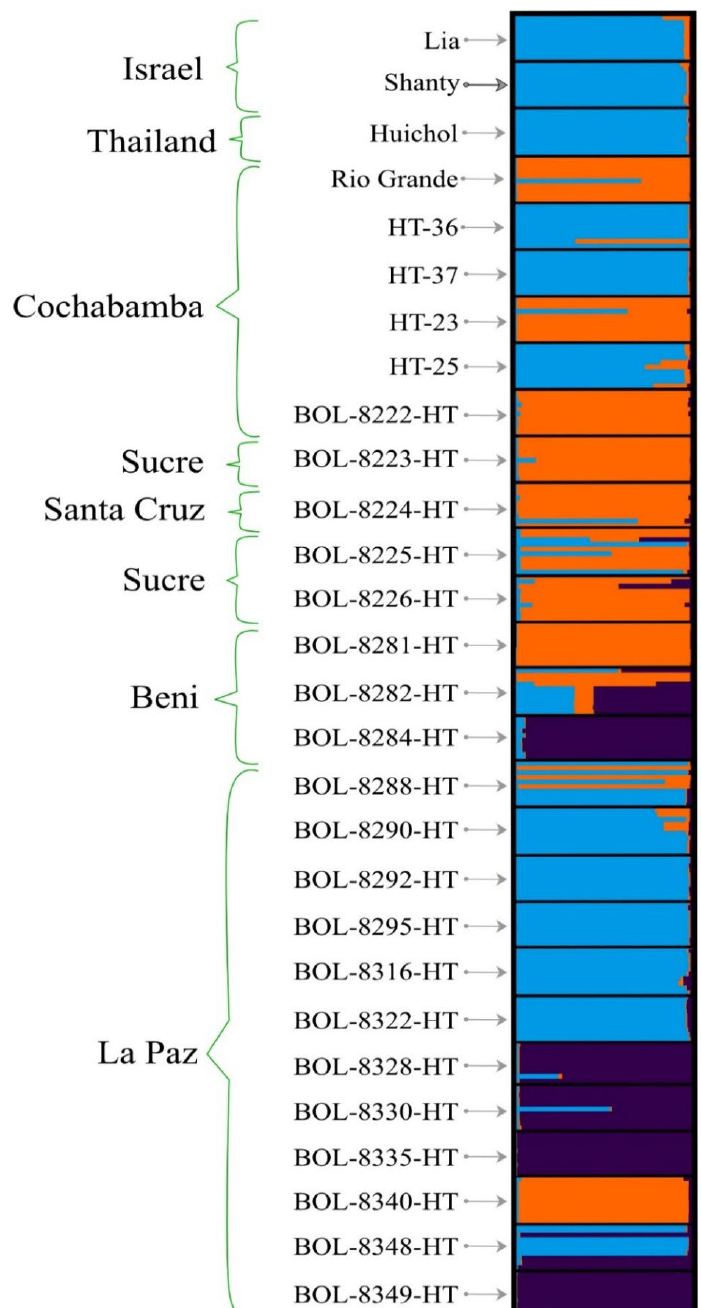
Figure 7. Graphical display of optimal genetic structure of the 279 individual genotypes representing the 28 tomato accessions. Light blue, yellow and deep purple represent the three clusters (K) identified in population structure analysis. In each accession, the proportion of each colour represents the average proportion of alleles that placed each accession in one or more cluster. A black rectangular border delimits each